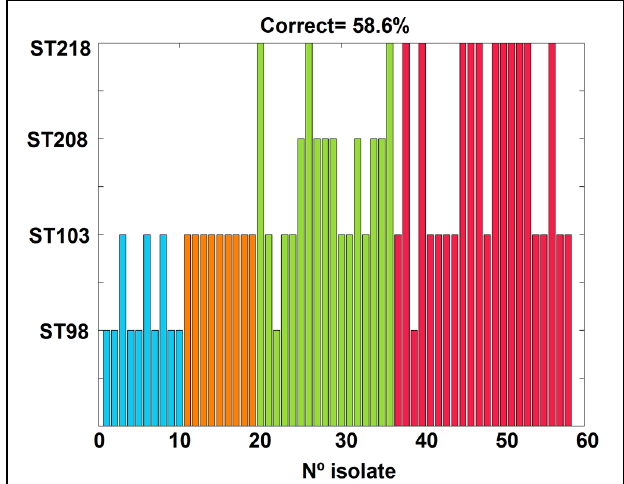
FIGURE 3 | Sequence type assignments for all isolates considering the spectral matching method. Colors identify the real ST of each isolate and bars correspond to the method’s ST predictions (58.6% of correct predictions). Legend: ST98, ST103, ST208, and